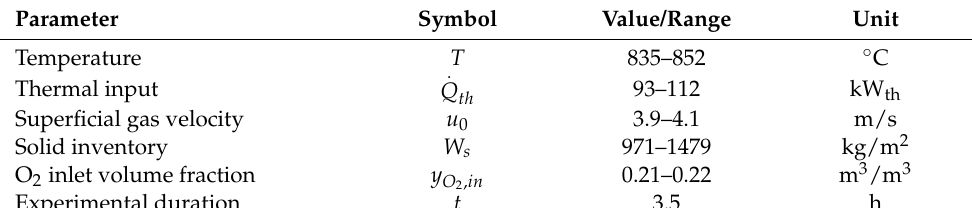
Table 3. Experimental range of the operating conditions.